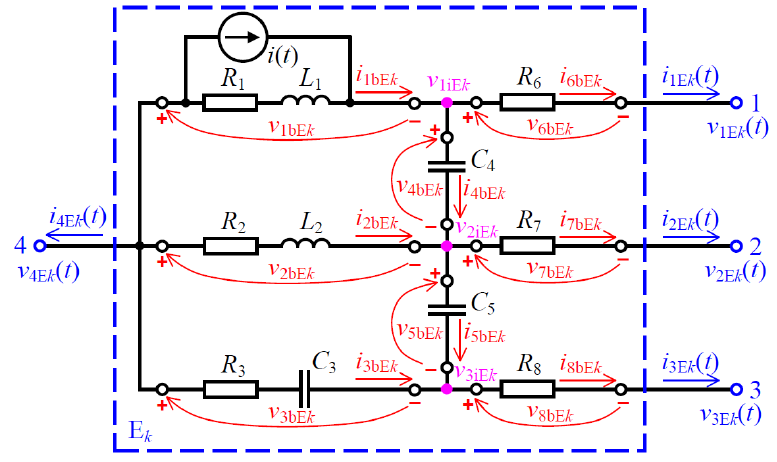
Figure 8. Schematic diagram of the internal structure of the example structural